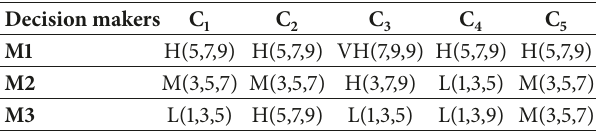
Table 4: Weighted criteria for three